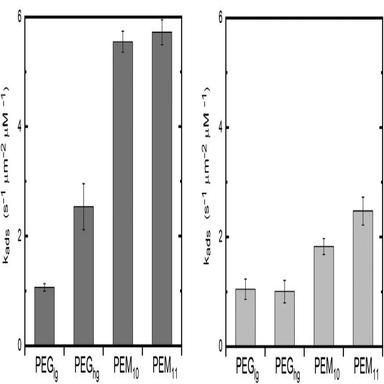
Average adsorption rate coefficients of albumin (left) and fibrinogen (right) under continuous flow (50 s − 1 shear rate) on PEG and PEM surfaces. Error bars represent the standard deviation (n = 3, independent experiments for each condition).